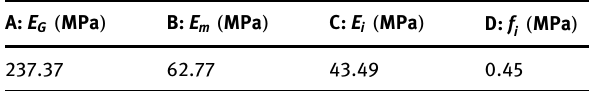
Table 8: Inversion calculation